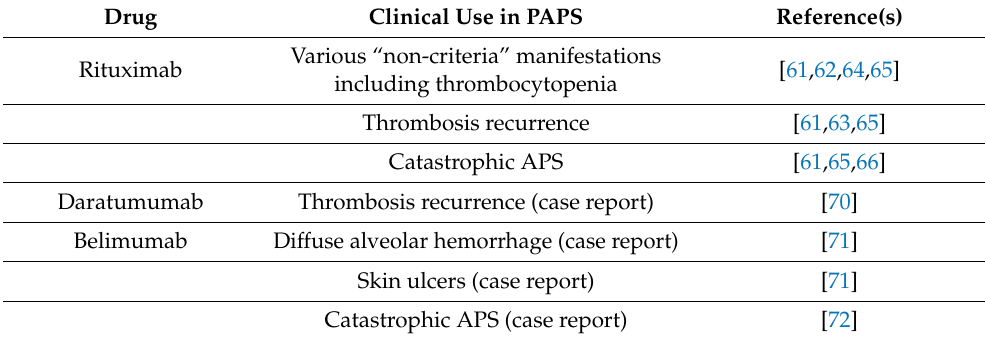
Table 2. Overview of clinical use of B-cell and BAFF targeting therapies in PAPS.